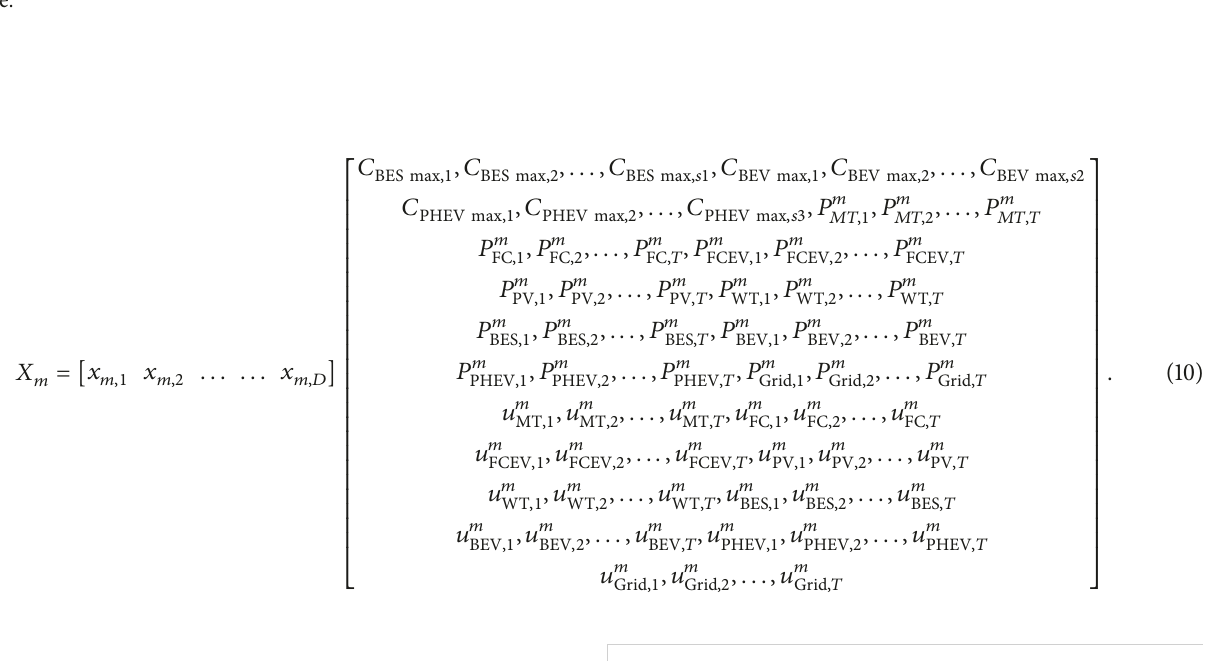
Figure 4: Search space, directional search history, trajectory in the first dimension, average function value of all sharks, and ASO convergence